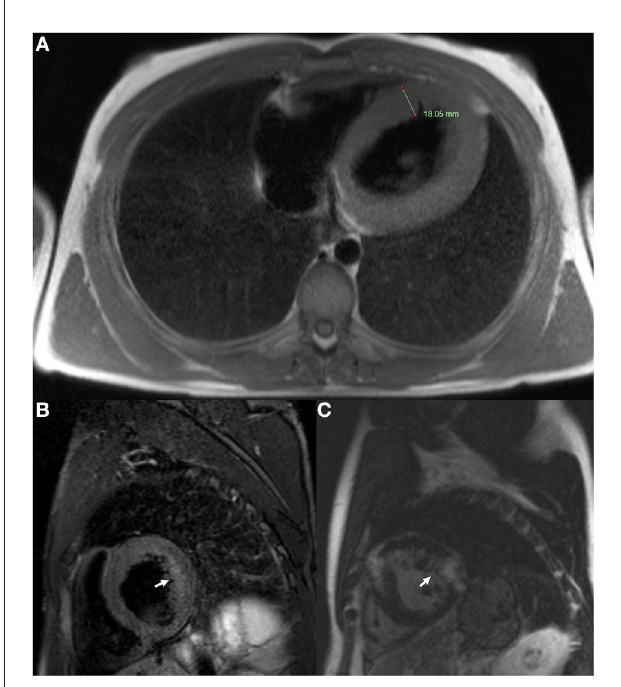
FIGURE4 Cardiac magnetic resonance imaging of Case 2 (III-1) at age 18. (A) Axial T2 sequence showed increased left ventricular wall thickness (18.05mm). (B) Short axis T2 fat saturation sequence showed increased signal in the mid ventricular wall (arrow). (C) Short axis